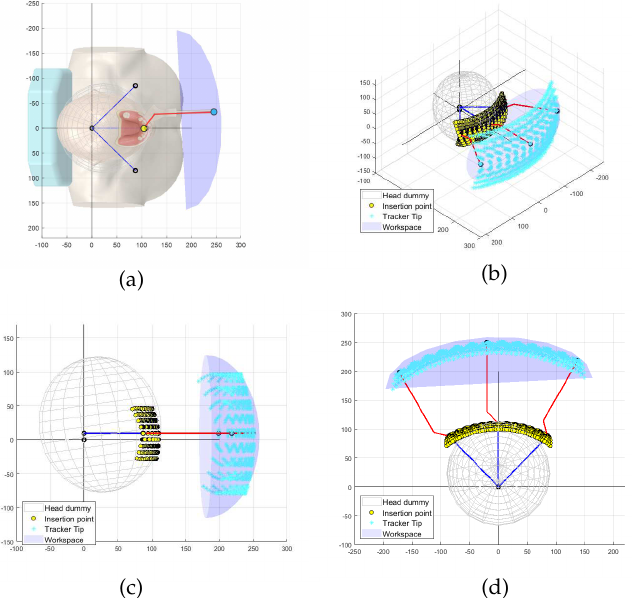
Figure 3. Simulated target workspace according to target head ROM (a) schematic diagram of end-effector; (b) perspective view; (c) side view; (d) top view.